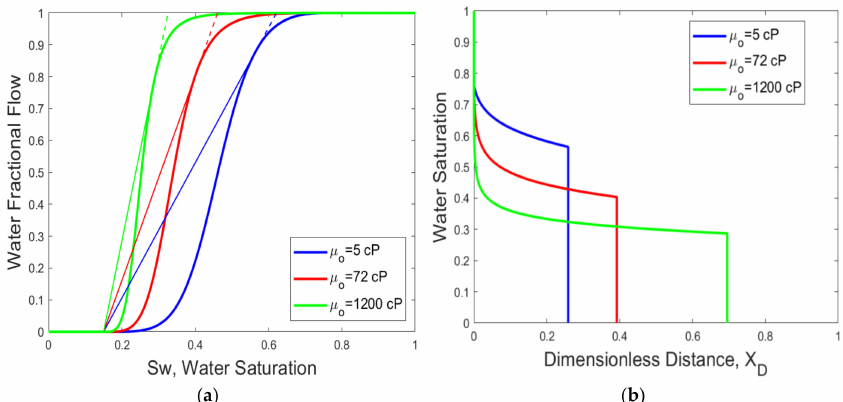
Figure 4. ( a ) Water fractional flow as a function of oil viscosity and construction of shock front; and ( b ) Water saturation profile at t D = 0.20 PV as a function of di ff erent oil viscosity during water flooding. The lines in green, red, and blue represent the cases of water flooding with high oil viscosity, moderate oil viscosity, and low oil viscosity, respectively.